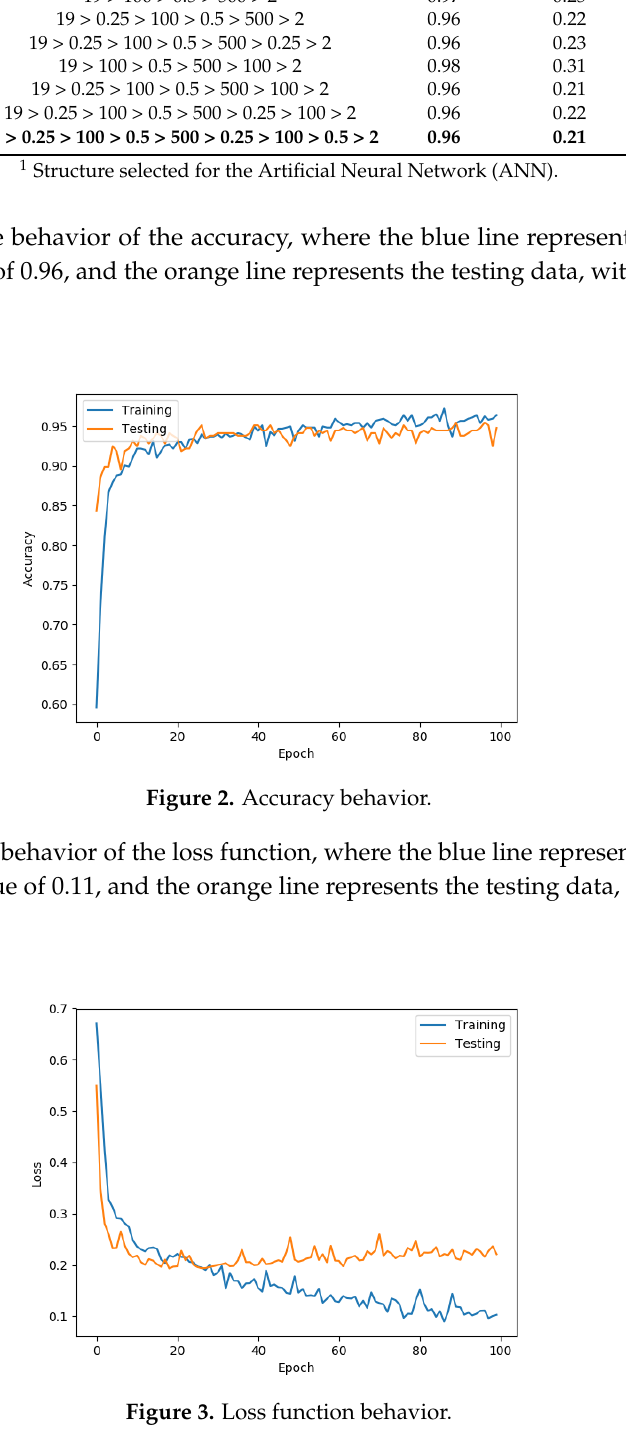
Table 3. Accuracy, loss function and processing time with different number of layers and neurons. Layers Dense/Dropout